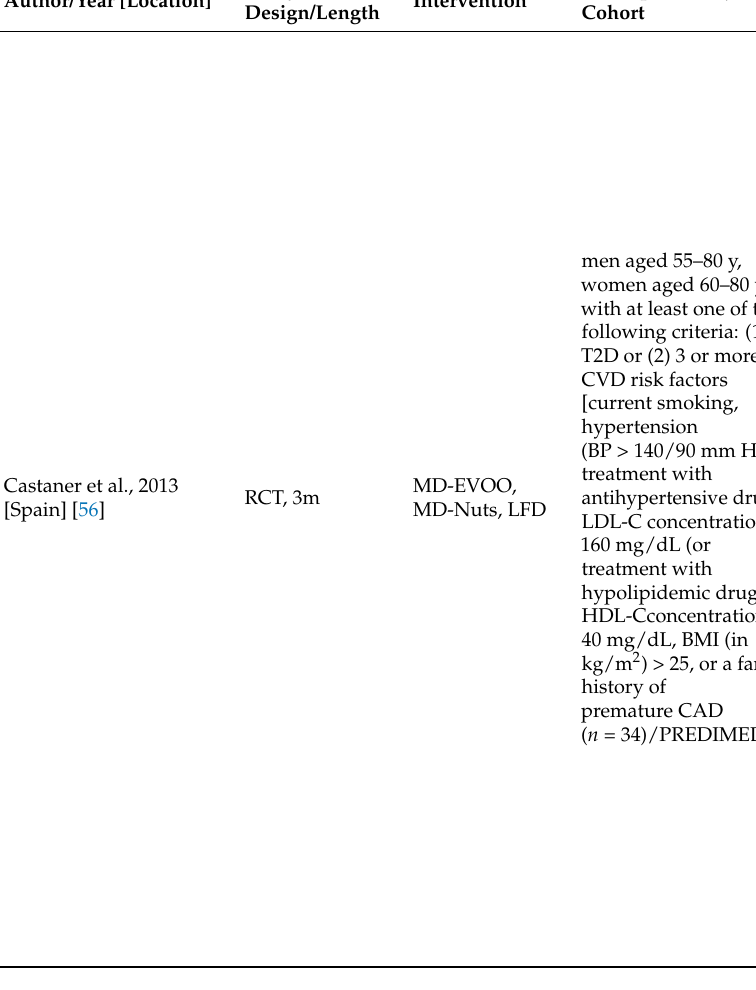
Table 2. Clinical Studies. Table 2. Cont. Table 2. Clinical Studies. Table 2. Clinical Studies. Table 2. Clinical Studies. Table 2. Clinical Studies. Table 2. Clinical Studies. Table 2. Clinical Studies. Table 2. Clinical